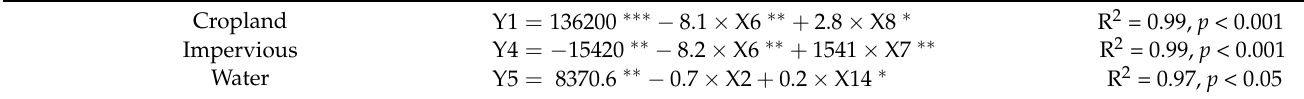
Table 6. Multivariate linear stepwise regression results of the area of land-use types and driving factors.